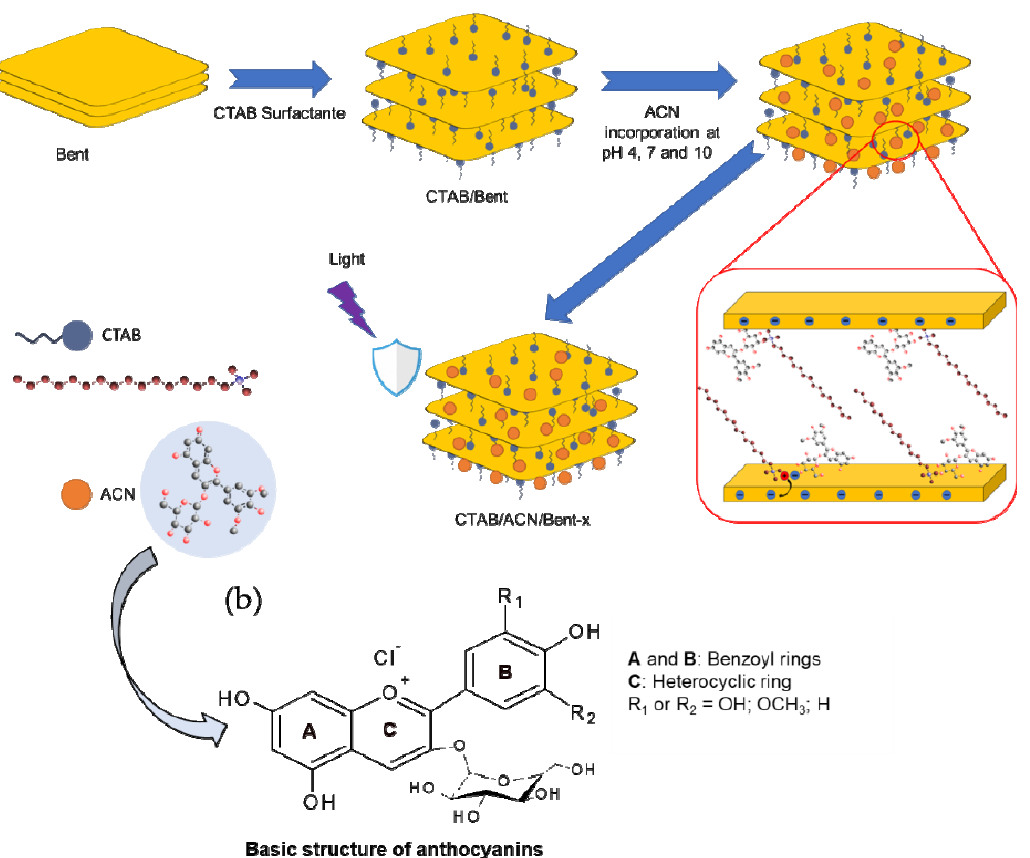
Figure 6. ( a ) Scheme relating the synthesis of the CTAB/ACN/Bentx hybrids and ( b ) basic structure of anthocyanins (ACN).